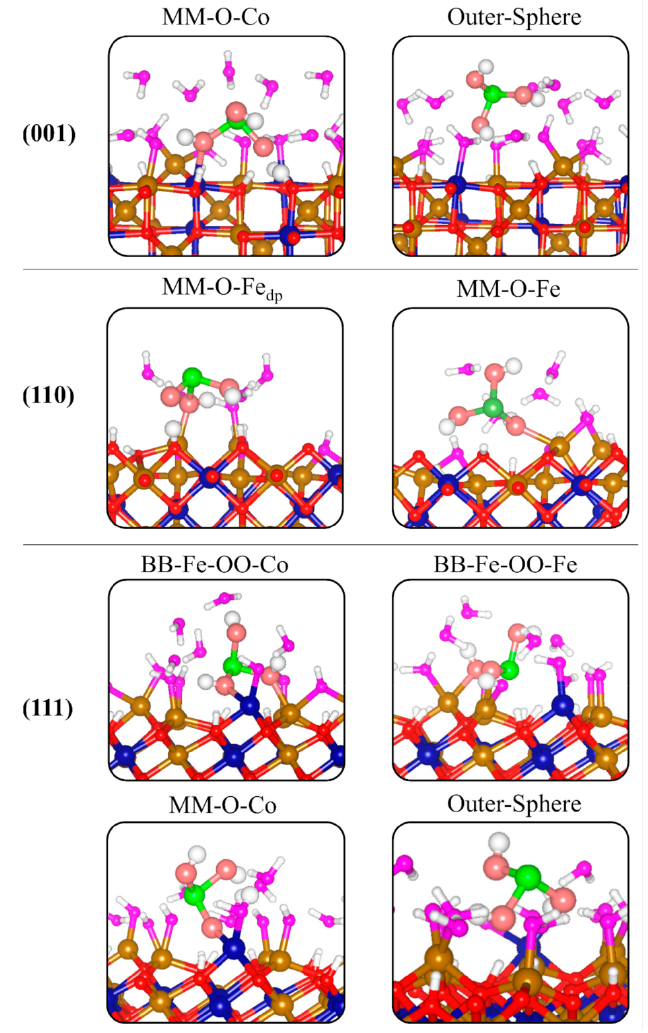
Figure 6. Optimised lowest-energy solvated unique configurations of H 3 AsO 3 on hydroxylated Fe 2 CoO 4 (001), (110), and (111) surfaces. H 3 AsO 3 molecules enlarged for clarity (Fe = brown, Co = blue, O surf = red, O H2O = magenta O mol = light pink, H =